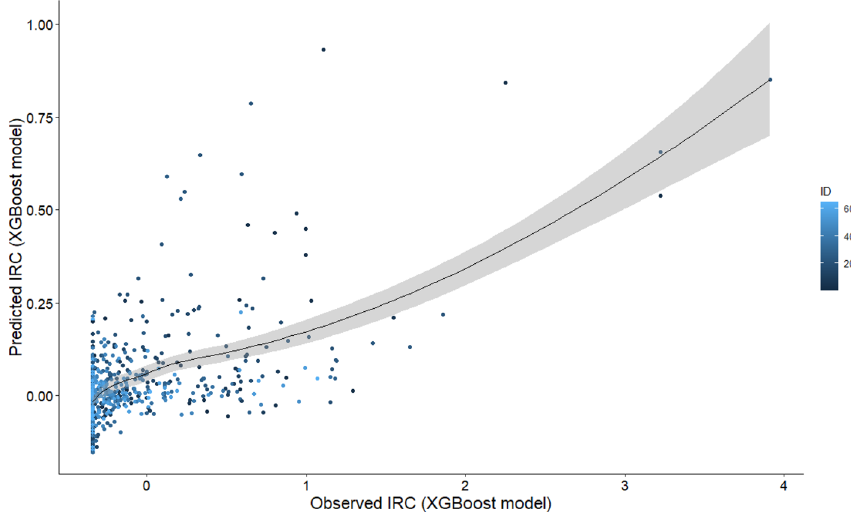
Figure 2. Scatter plot of predicted IRC versus observed values using the XGBoost method.